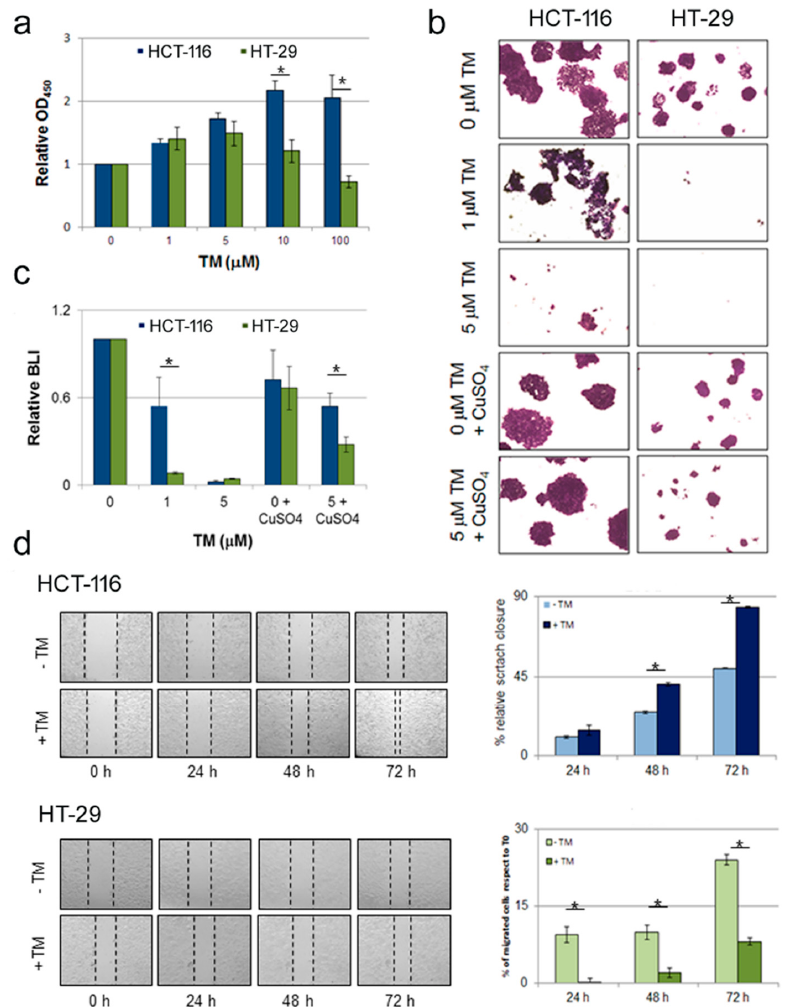
Figure 1. Copper chelation selectively affects proliferation, survival and migration of colon cancer HT-29 cells bearing BRAF V600E mutation compared to HCT-116 cells carrying BRAF wt . (a) Copper proliferation and survival of colon cancer cells bearing BRAF V600E mutation. Colon cancer cell lines